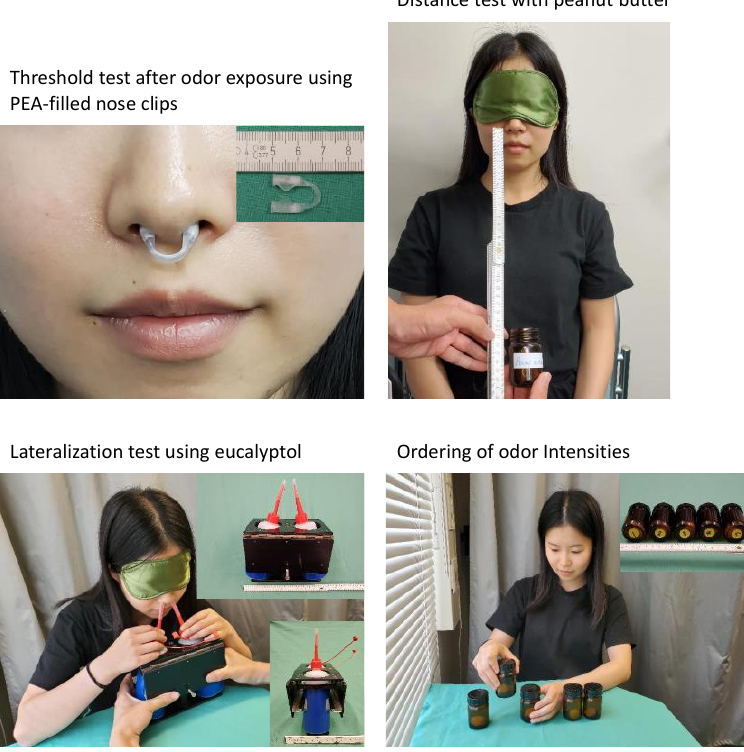
Figure 1. Photographs showing details of the administration of olfactory tasks. Top left – nasal clip (see also insert) filled with phenylethylalcohol to provide continuous olfactory background stimulation. Top right — distance test with an opened jar with peanut butter slowly moved upwards towards the nose of the blinded participant with a meter to measure the distance from the nares. Bottom left — lateralization task using a hand-held squeezing device (see also inserts), which allows to administer the same amount of air to the left and right nostrils of the blinded participant with one bottle containing eucalyptus. Bottom right — odor-sorting task with the participant arranging odor-containing bottles according to the different odor intensities with odor concentrations indicated at the bottom of the bottle (see also insert).